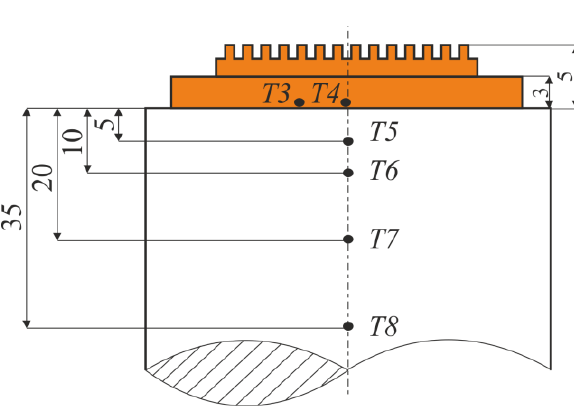
Fig. 3. Arrangemet of